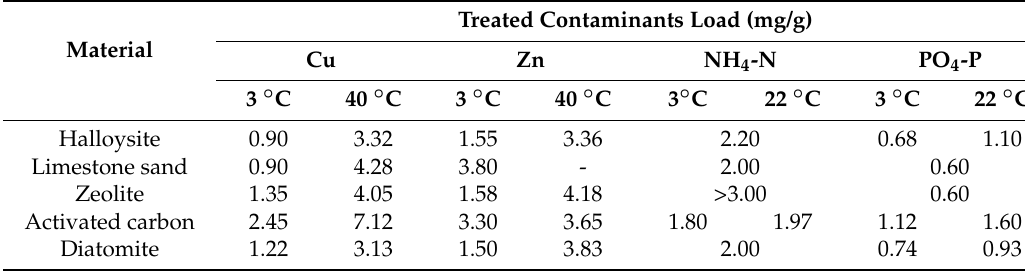
Table 5. Values of contaminants load